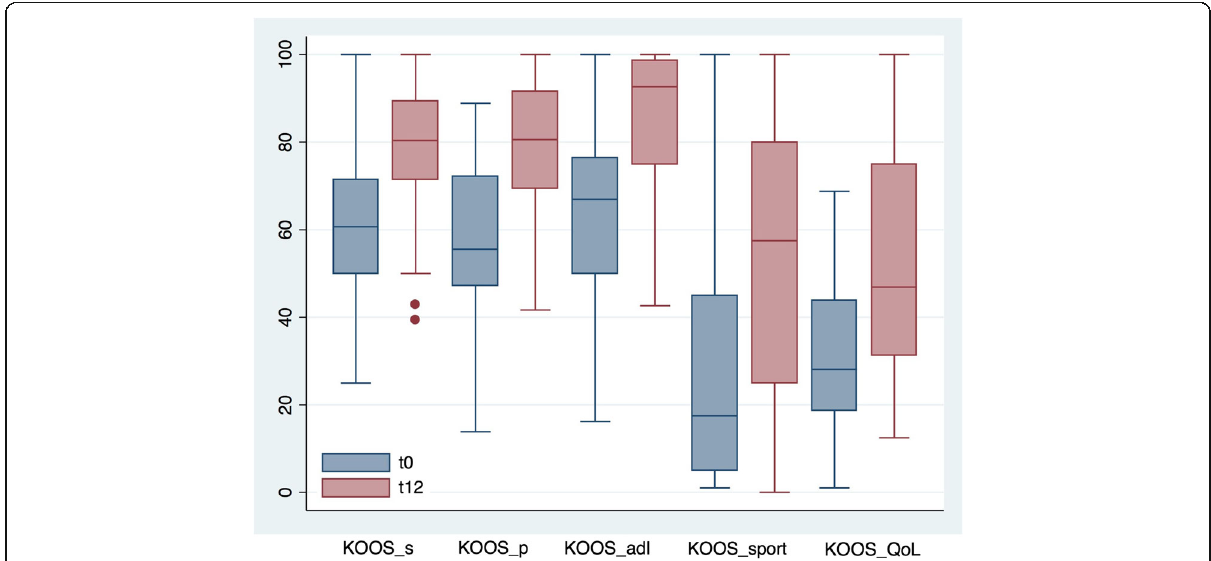
Fig. 3 Box plot of the five KOOS subscale scores pre-operatively (t0) and at 12 months (t12) after micro-fragmented adipose tissue injection. Results are expressed as median and interquartile range. KOOS S = symptoms; KOOS P = pain; KOOS ADL = activity daily living; KOOS Spt = sport; KOOS QoL = quality of